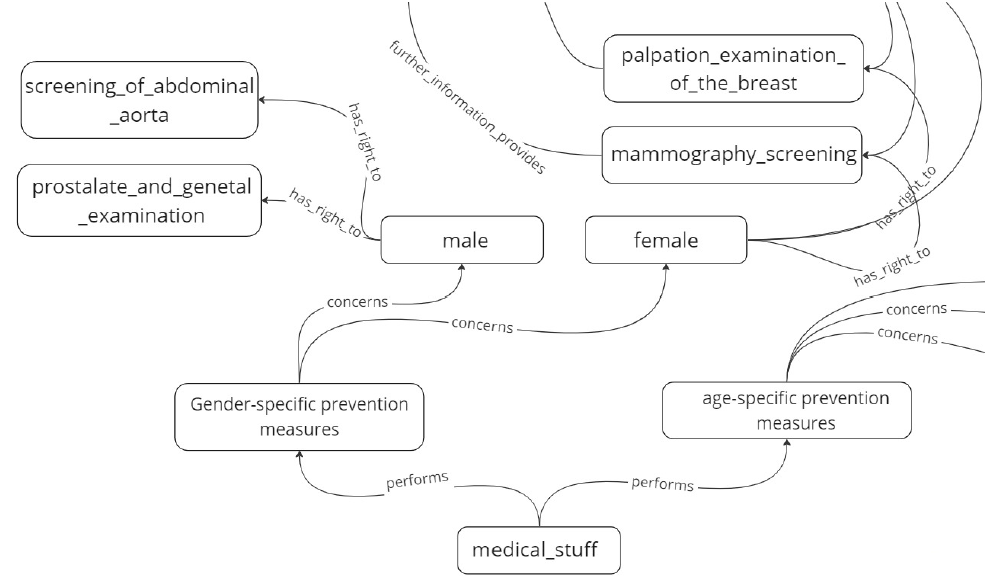
Figure 4. Excerpt from the knowledge graph for the medical prevention domain.